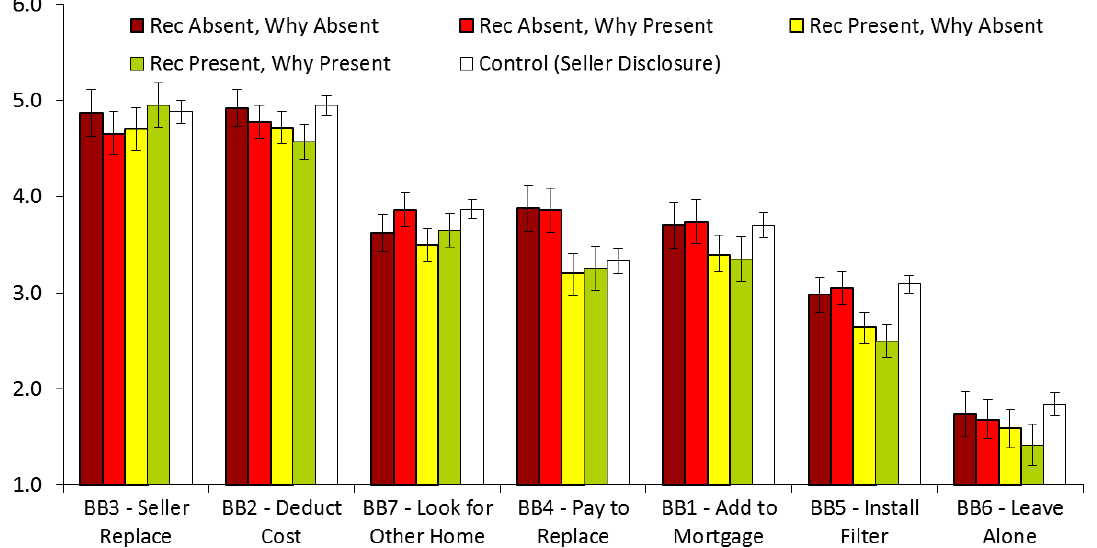
Figure 4. Willingness to adopt risk mitigation behaviors, by inspector/buyer condition. Error bars indicate 95% confidence intervals with Bonferroni corrections.